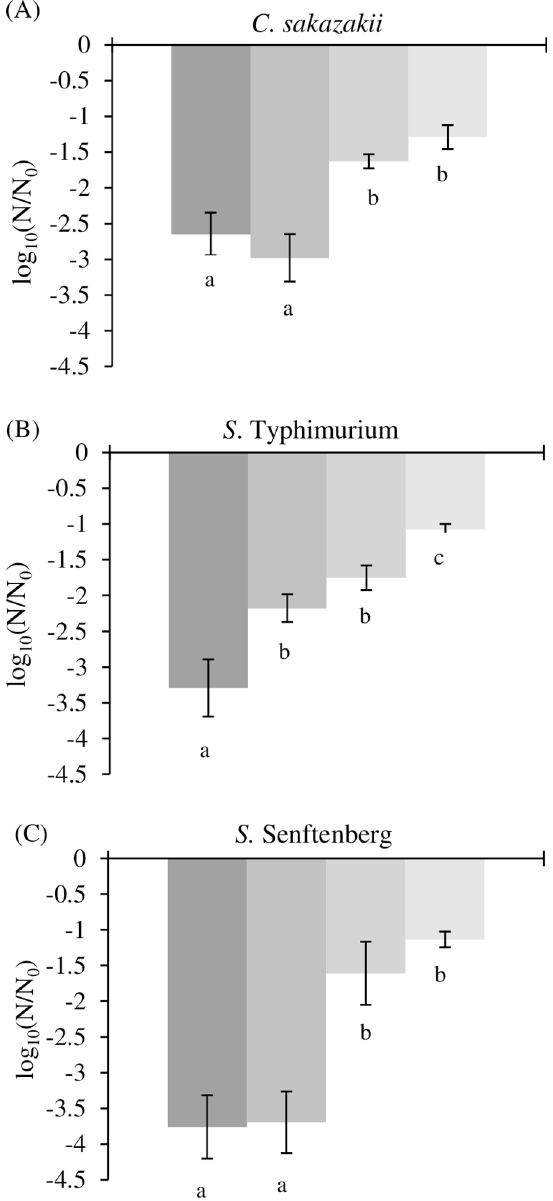
Fig 3. Comparison of four rehydration kinetics after 90 min of drying in an atmosphere at 11% RH for C . sakazakii (A), S . Typhimurium (B) and S . Senftenberg (C). The loss of cultivability obtained with instantaneous, rapid, slow and very slow rehydration is shown going from darker to lighter. Error bars represent SD calculated from independent triplicates. The letters represent a significant difference (p < 0.05) obtained with Tukey's HSD (Honest Significant Difference) test. The corresponding dataset was presented in S2